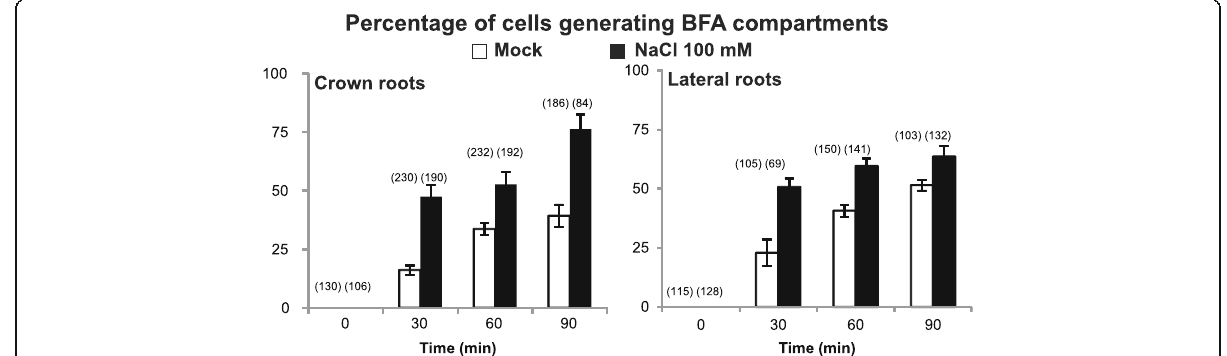
Fig. 5 Effects of salt stress on the dynamics of brefeldin A (BFA) compartment labelling by Os PIP2;5 constructs in rice root cells. Root systems of Os PIP2;5-GFP expressing line were incubated in either water (mock condition; open bars) or 100 mM NaCl (closed bars), both supplemented with 50 μ M BFA. The number of cells with at least one labelled BFA compartment was counted from images acquired by confocal microscopy, from time 0 to the indicated times. This number was then normalized to the total cell number observed of each root type (crown and lateral roots). Numbers in parentheses indicate the number of cells observed in each assay. The mean values and ± SEs are